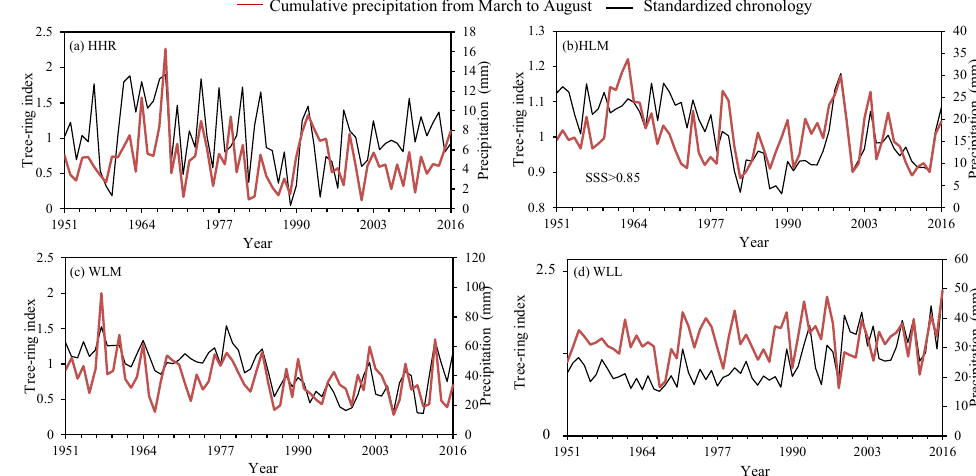
Figure 5. Comparison of tree-ring chronology and local cumulative precipitation from March to August.